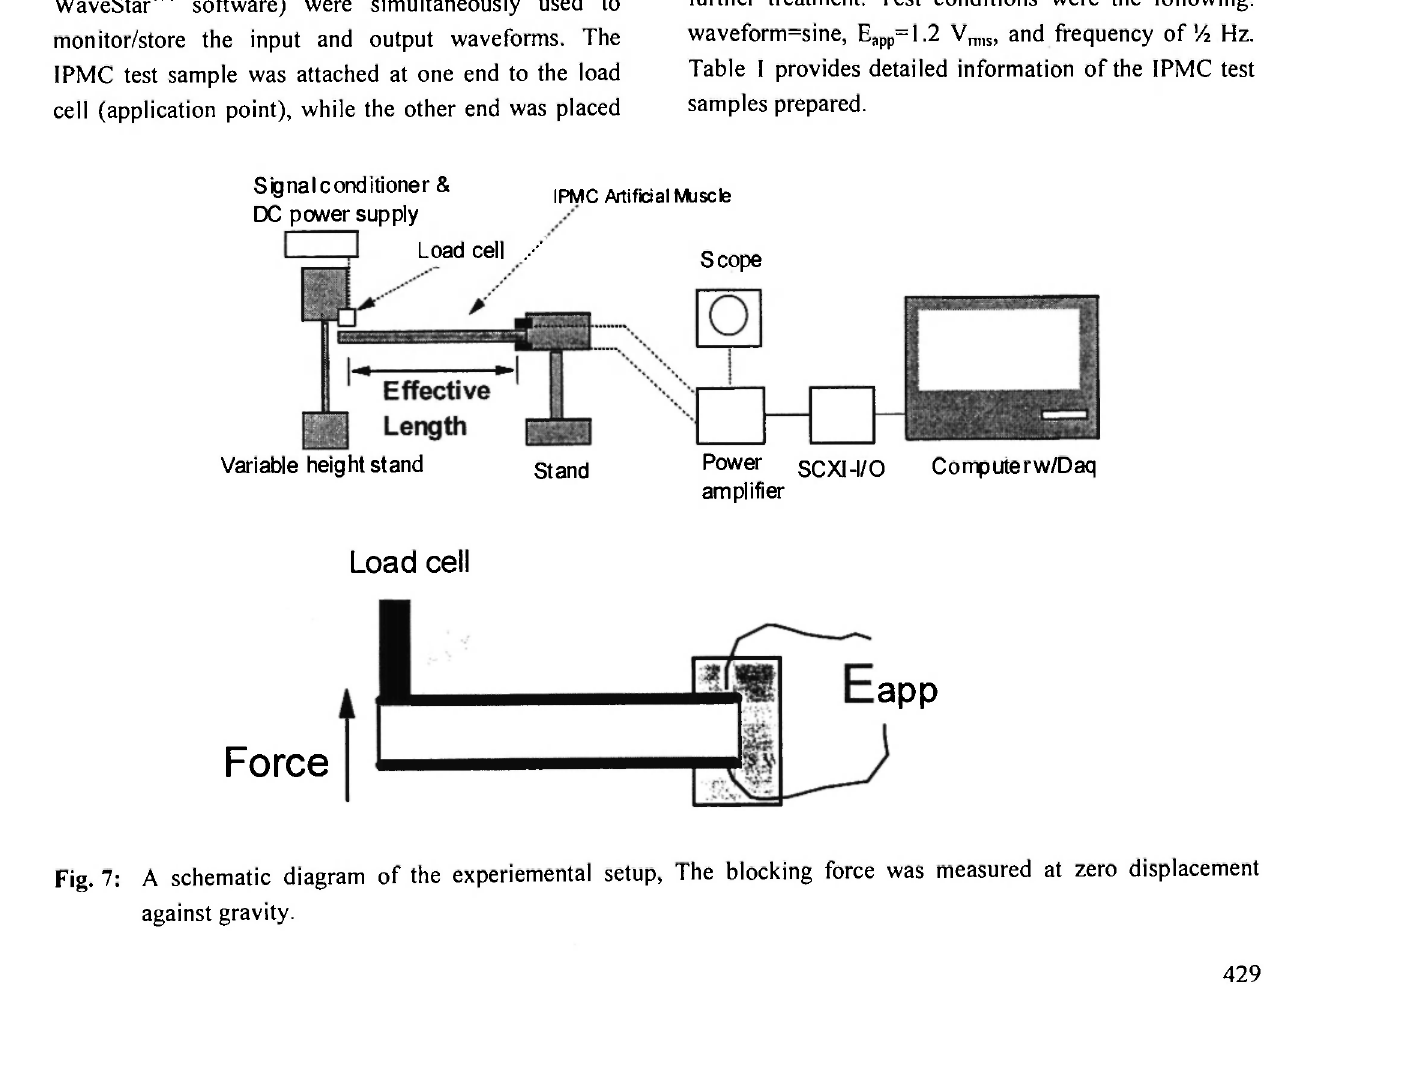
Fig. 7: A schematic diagram of the experiemental setup, The blocking force was measured at zero displacement against